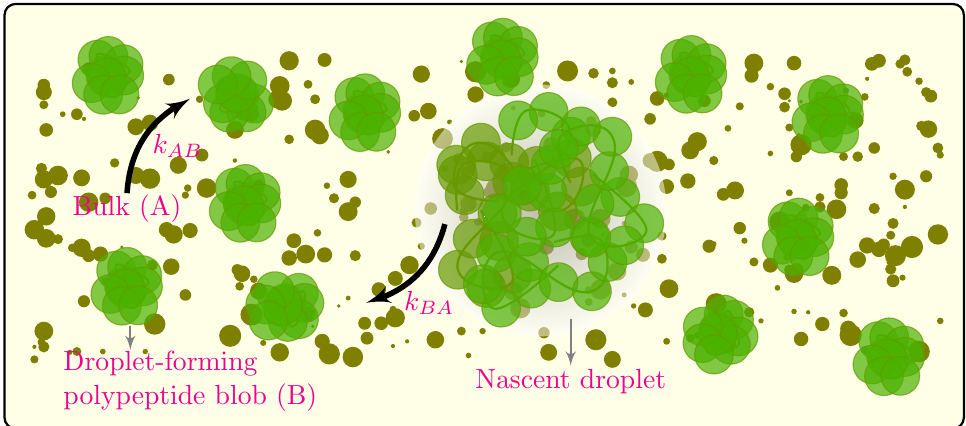
Figure 1. A cartoonistic representation of phase separation and bulk–polypeptide interaction kinetics in a macromolecular crowded environment under poor solvent regime. The polypeptides are as- sumed to be under local thermal equilibrium such that blob–solvent interactions result in the proteins taking globular conformations. At critical concentrations of the macromolecules, the polypeptide blobs go through a phase separation process whereby blobs aggregate into droplets with the blobs leaving the bulk at a rate k AB and disassociating from the droplet at a rate k BA